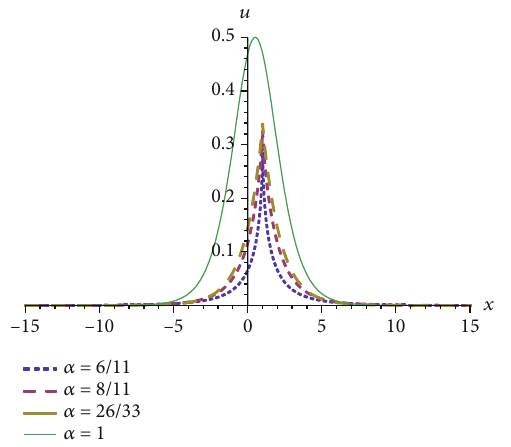
Figure 6: Pro fi les of fractional one-soliton u with di ff erent orders by selecting a = 1 , b = 1 : 5 , c = 0 , k 1 = 1 , p 1 = 1/2 , σ = 1 , ξ ð and t = 0